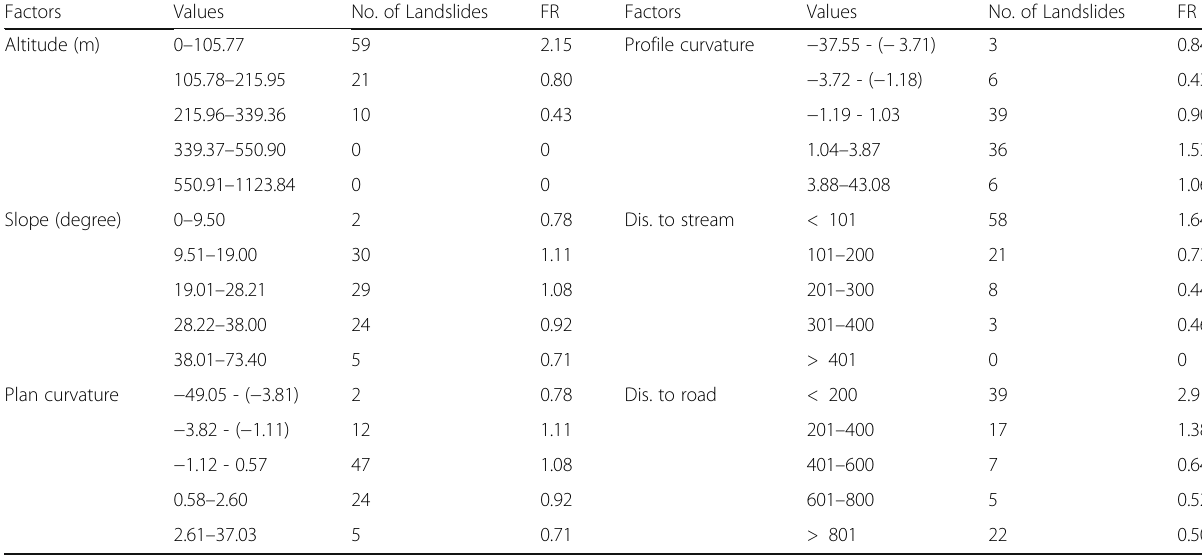
Table 1 Description and frequency ratio (FR) of topographical and distance to factors in the study area Factors Values No. of Landslides FR Factors Values No. of Landslides FR Altitude (m) 0 –